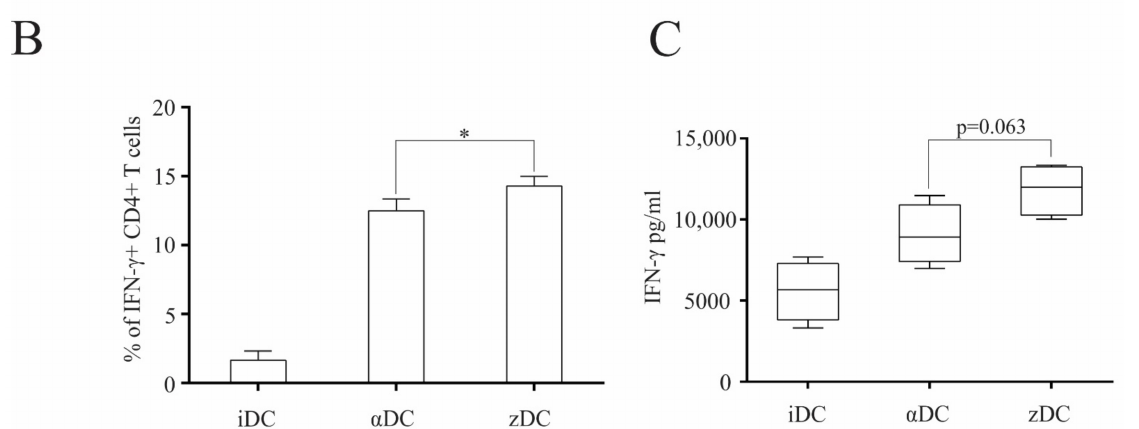
Figure 4. zDCs are efficient at inducing Th1 polarization of naïve CD4+ T cells. Dendritic cells were prepared as described in the Materials and Methods. ( A ) Their T cell polarization capac- ity was determined by performing co-cultures of variously treated DCs with allogeneic, naïve CD4+CD45RA+ T cells (48-well plates, 2 × 10 5 DCs with 2 × 10 6 naïve T cells) in RPMI medium supplemented with 10% human AB serum. After 7 days, the T cells were collected, re-stimulated, and stained intracellularly against IL-2, IL-10, and IFN- γ . Numbers in quadrants represent the percent- age of positive cells. Shown is one representative out of four independent experiments